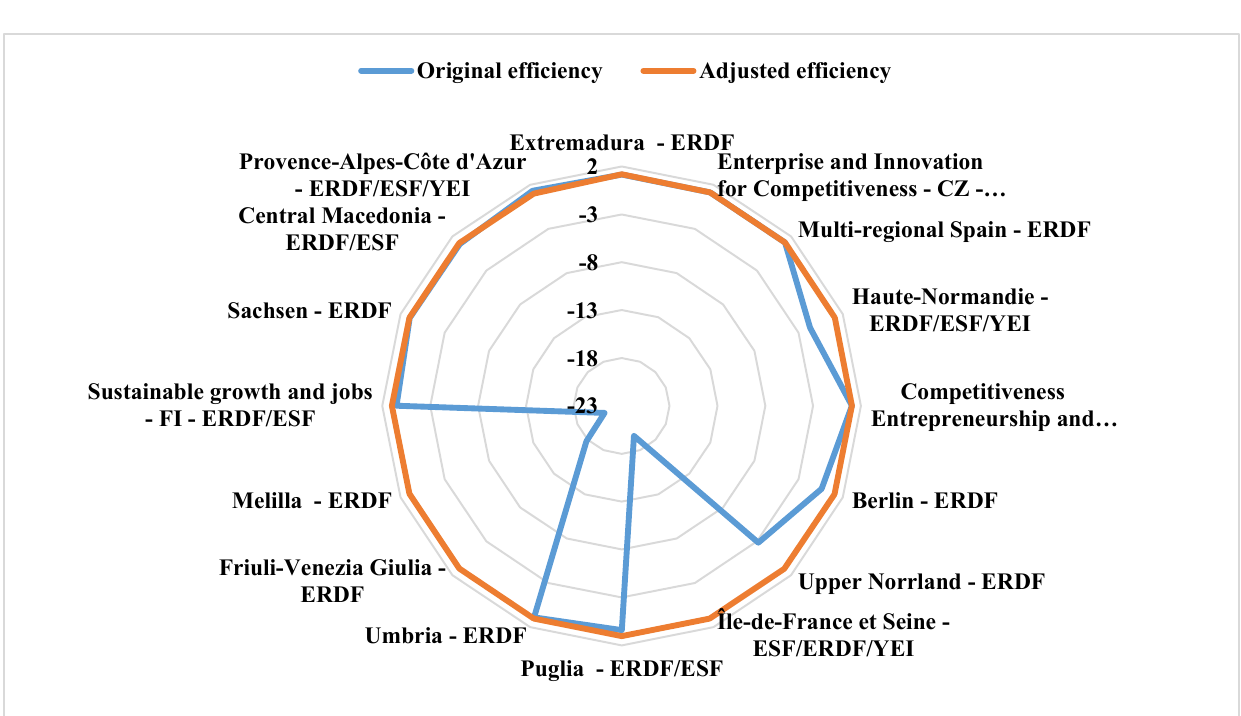
Figure 8. Original vs. adjusted efficiency scores for the 16 efficient OPs obtained with adjusted factors.